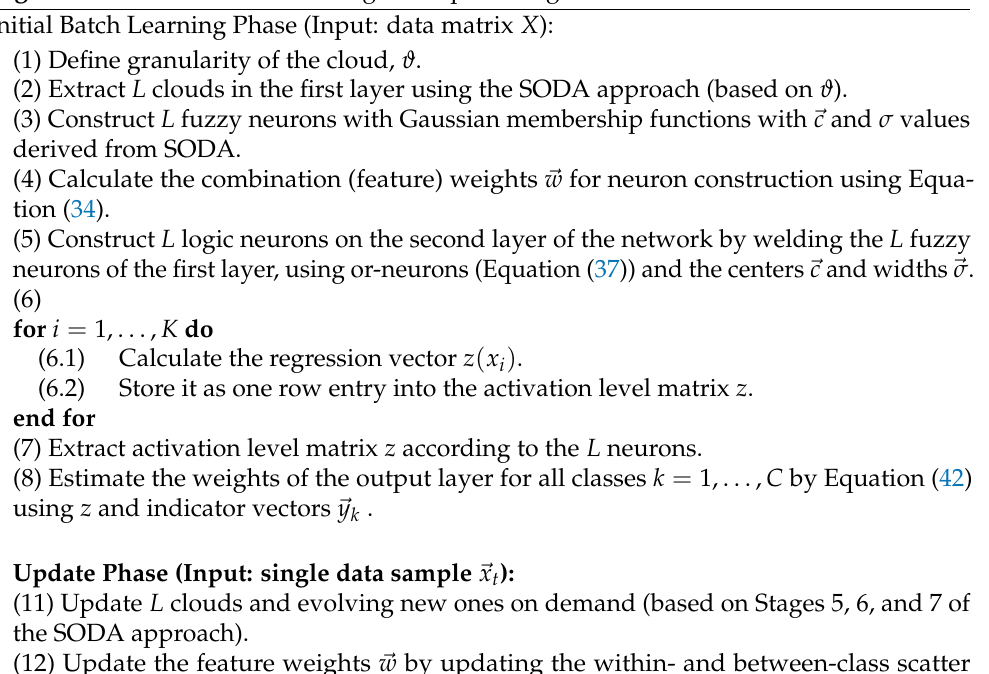
Algorithm 1 eFNN-SODA Training and Update